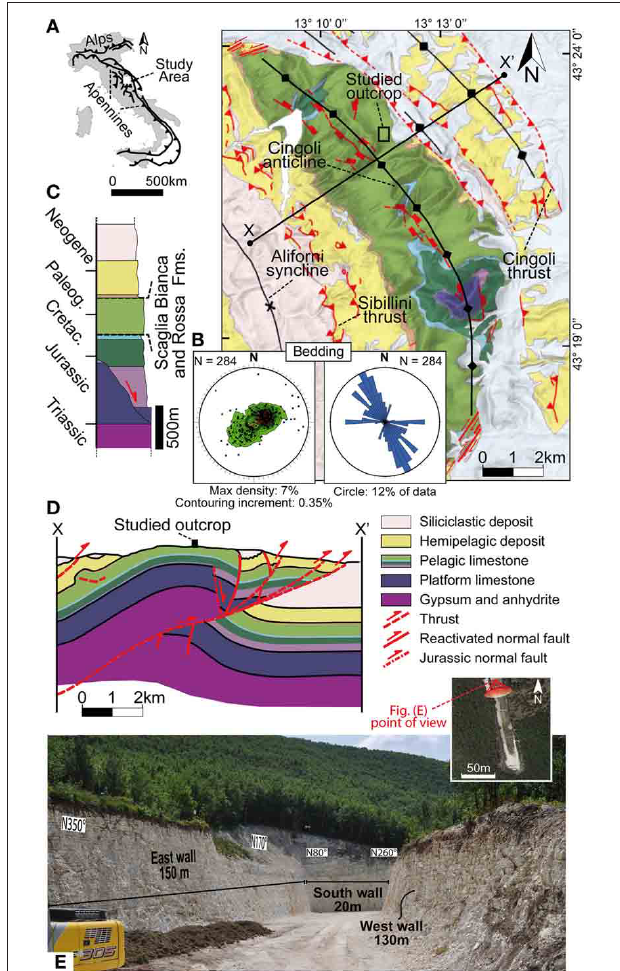
FIGURE 2 | Geological setting of the study area (Cingoli anticline, northern Apennines, Italy). (A) Location of the study area in Italy. (B) Geological map of the Cingoli anticline area plotted over a 3D rendering of a digital elevation model (vertical exaggeration = 2). The Schmidt net (lower hemisphere) shows bedding poles and related contouring for the entire Cingoli anticline (attitude data are from Carta Geologica D’Italia, 2009). The rose diagram shows bedding strikes (same bedding data as in the adjacent Schmidt net). These data show that the anticline is more arcuate dome-like than cylindrical (see also Table A1 ). The Schmidt net and rose diagram were produced with the Open Plot software by Tavani et al. (2011). (C) Simplified stratigraphic column of the study area. The marly limestone with chert studied in this work (Scaglia Bianca Fm.) is indicated within the pelagic limestone sequence typical of northern Apennines. (D) Geological cross-section through the Cingoli anticline (modified from Mazzoli et al., 2002). See the X–X’ track in Figure 1B . The study outcrop is located in the crestal (hinge) region of the Cingoli anticline and its location is indicated along the cross-section with a black rectangle. (E) Photograph of the studied exposures. Inset shows an aerial image from Google Maps displaying the study outcrop that is a trench-like shooting range recently carved into the Cingoli anticline hinge for a depth of about 15–20m (latitude: 43 ◦ 22 (cid:3) 29.81 (cid:3)(cid:3) N; longitude: 13 ◦ 11 (cid:3) 38.85 (cid:3)(cid:3) E; elevation: